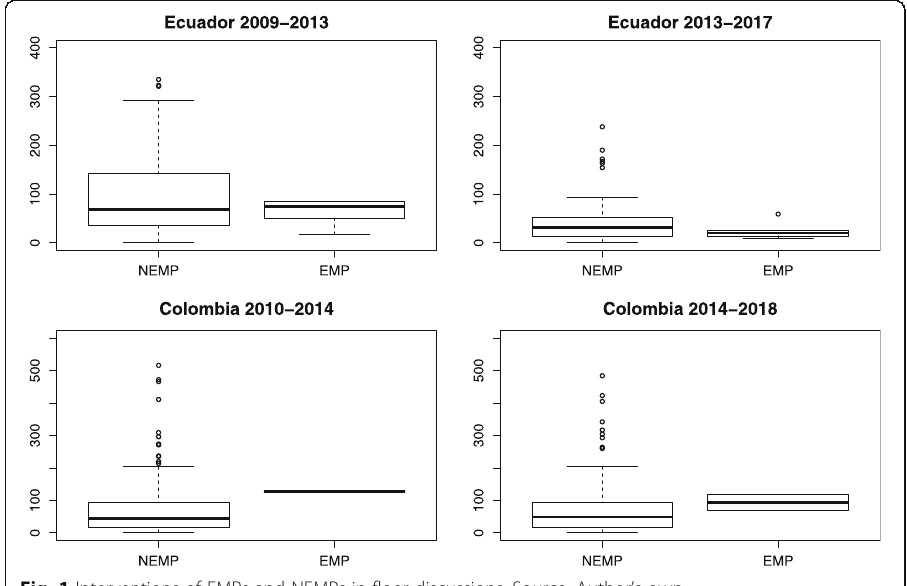
Fig. 1 Interventions of EMPs and NEMPs in floor discussions. Source: Author ’ s